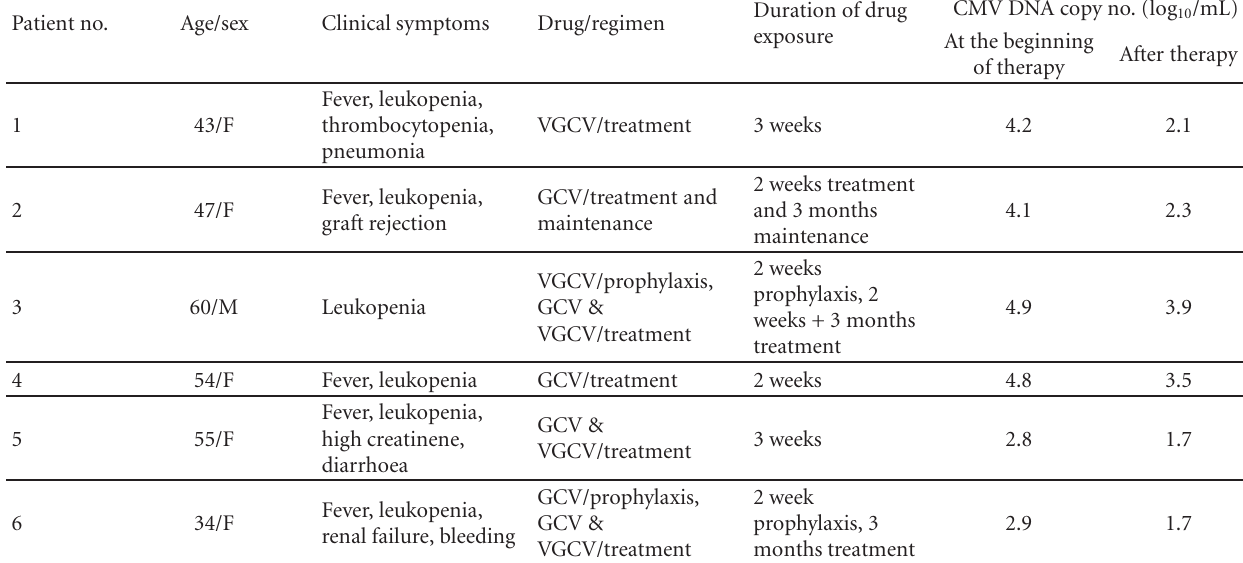
Table 3: Characteristics and outcomes of six patients with clinically suspected drug-resistant CMV. Patient